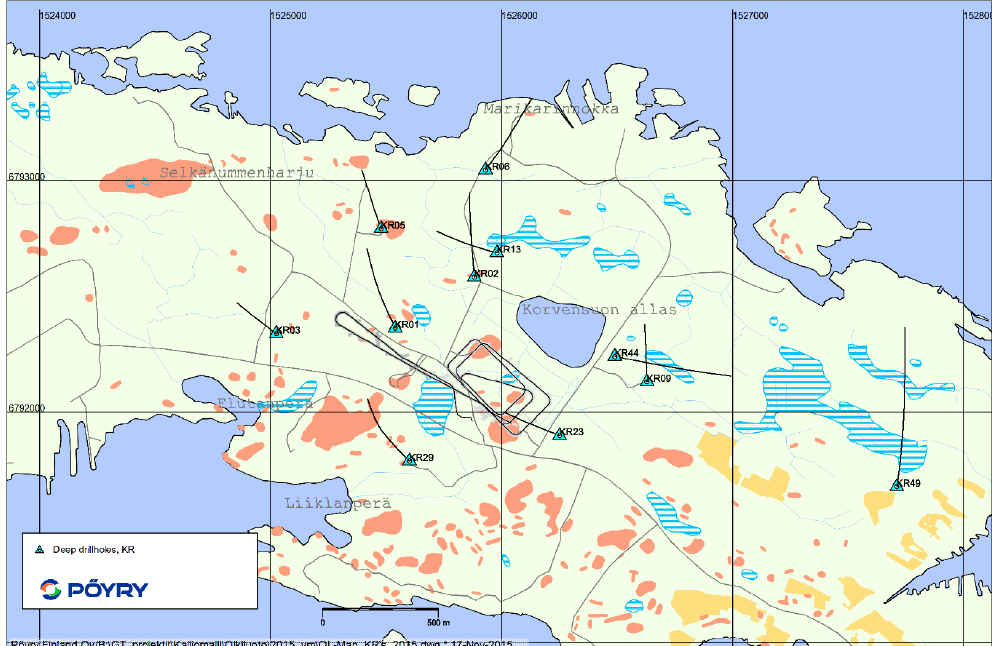
Figure 1. Map of Olkiluoto. The boreholes used in this study are marked with a turquoise triangle and the attached black line depicts the direction of the borehole (with courtesy of Pöyry Oy, 17 November 2015, by Eemeli